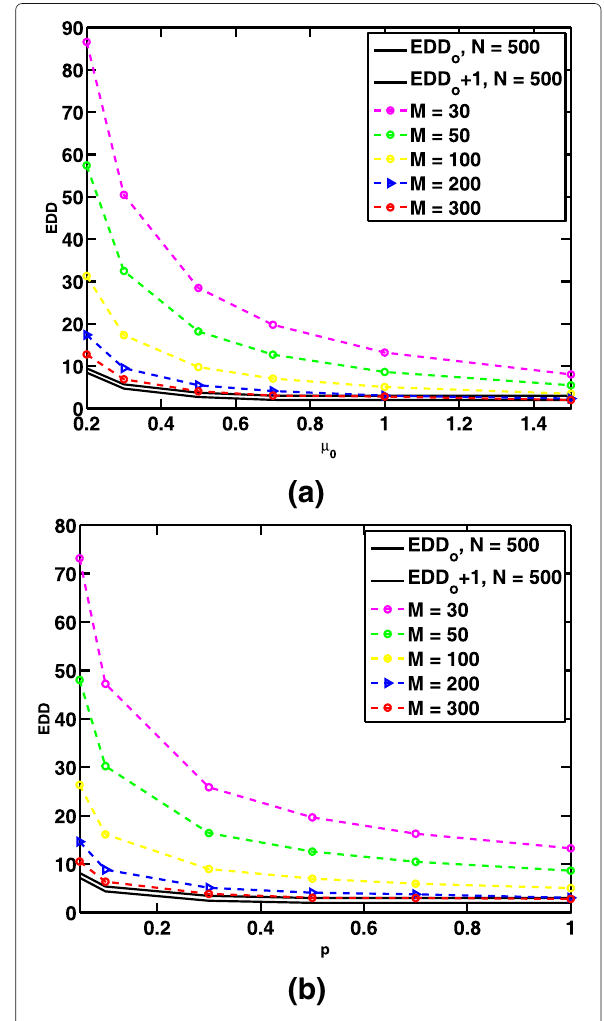
Fig.8 A (cid:5) t s are time-varying projections. The standard deviation of each point is less than half of its value. a EDD versus μ 0 , when all [ μ ] i = μ 0 ; b EDD versus p when we randomly select 100 p % entries [ μ ] i to be 1 and set the other entries to be 0; the smallest value of p is